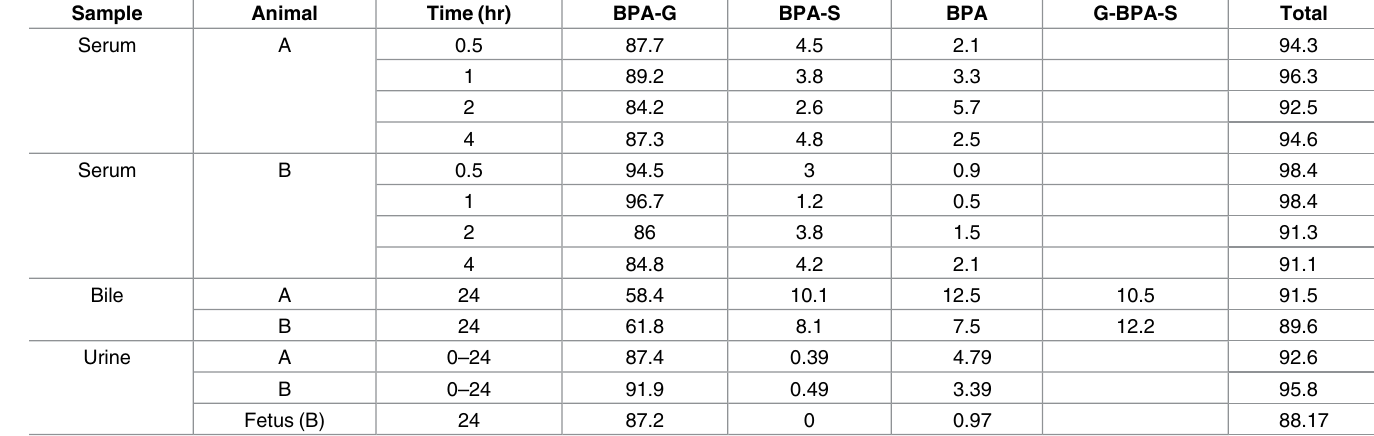
Table 3. Respective radio-HPLC percentages of BPA glucuronide (BPA-G), BPA sulfate (BPA-S), unconjugated BPA, and a double glucuronide/ sulfate conjugate of BPA (G-BPA-S, bile only) in monkey serum, bile, and urine samples. A = non pregnantanimal.B = pregnantanimal. Sample Animal Serum